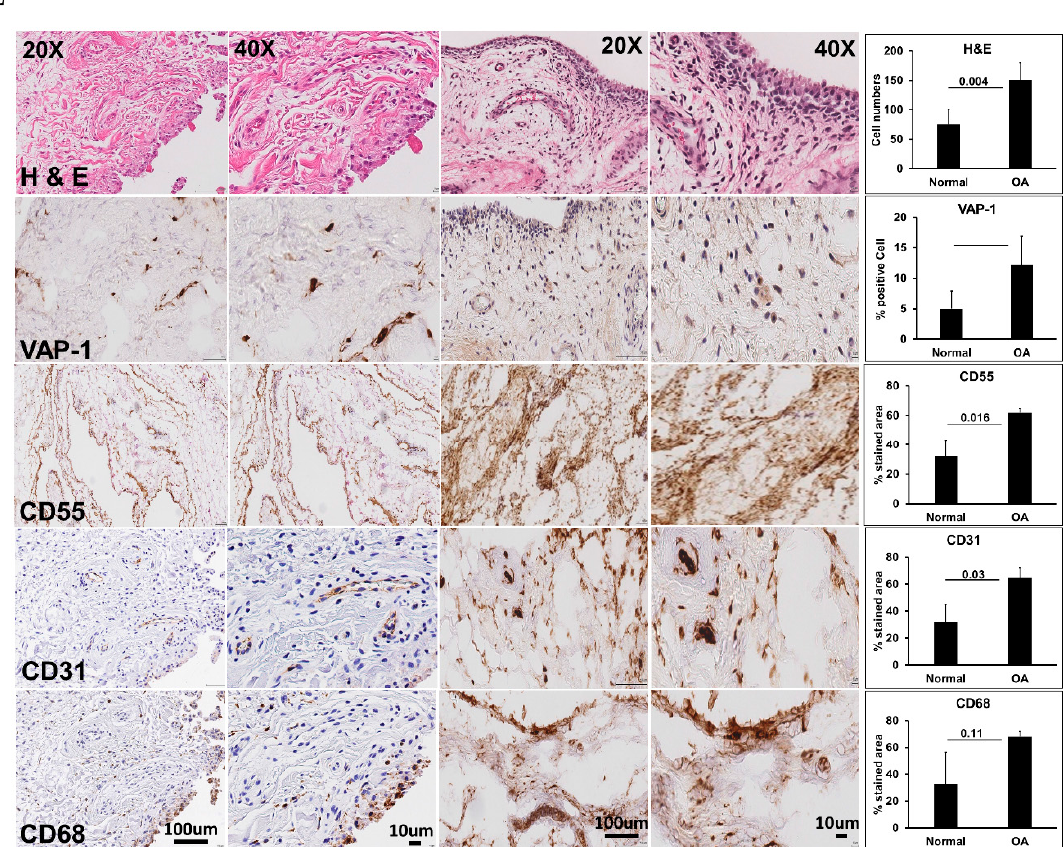
Figure 1. Vascular adhesion protein-1 (VAP-1) levels were elevated in osteoarthritis (OA) synovium and sVAP-1 levels in OA synovial fluid. ( A ) ELISA of sVAP-1 in the synovial fluid of control (normal) and OA patients; ( B ) Comparison of synovial fluid sVAP-1 levels in radiographic Kellgren–Lawrence (KL) (KL 1–4) groups in OA patients; ( C ) Microarray analysis of VAP-1 expression in synovial tissue. Total RNA from seven normal and OA synovia was hybridized to human U133A arrays. After normalization, VAP-1 expression was shown in arbitrary units; ( D ) Real-time quantitative polymerase chain reaction (qRT-PCR) analysis of VAP-1 mRNA in 11 normal and 11 OA synovium specimens from knee joints; ( E ) Immunohistochemical analysis of VAP-1 in normal and end-stage OA knee synovium. OA knee synovium sectioned and stained for VAP-1 with vectastain reagents (Vector Laboratories, Burlingame, CA, USA). Representative H&E, VAP-1, CD55, CD31, and CD68 images are shown. Leica SCN400F scanned the whole slide at bright-light and 40× magnification (0.25 μ m/pixel). The images are shown with scale bar 100 μ m and 10 μ m. For synovium tissue slides stained with H&E and VAP-1, positive cells were counted using magnified photos on four sections per specimen, and cell numbers were averaged by each sample. CD55, CD31, and CD68 immunohistochemical staining were shown as a percentage of the staining area in the region of interest. Photos were analyzed with Image J by converting RGB (red, green, and blue) photos into binary images, and the stained areas were lined out and analyzed. One-way analysis of variance (ANOVA) ( D ) determined p values or nonparametric Mann–Whitney test between control and OA groups ( A , C , D ). Symbols represent individual subjects; bars show mean and standard deviation. N : number of individuals whose samples were tested.